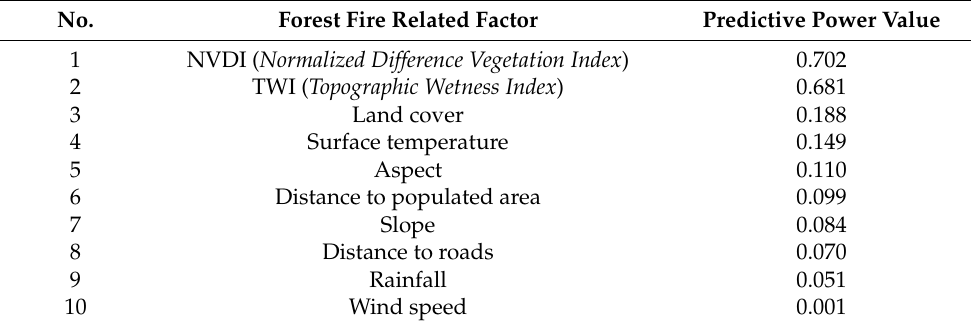
Table 1. Predictive power of the ten forest fire related factors using the Pearson correlation method. No. Forest Fire Related Factor Predictive Power Value NVDI ( Normalized Difference Vegetation Index